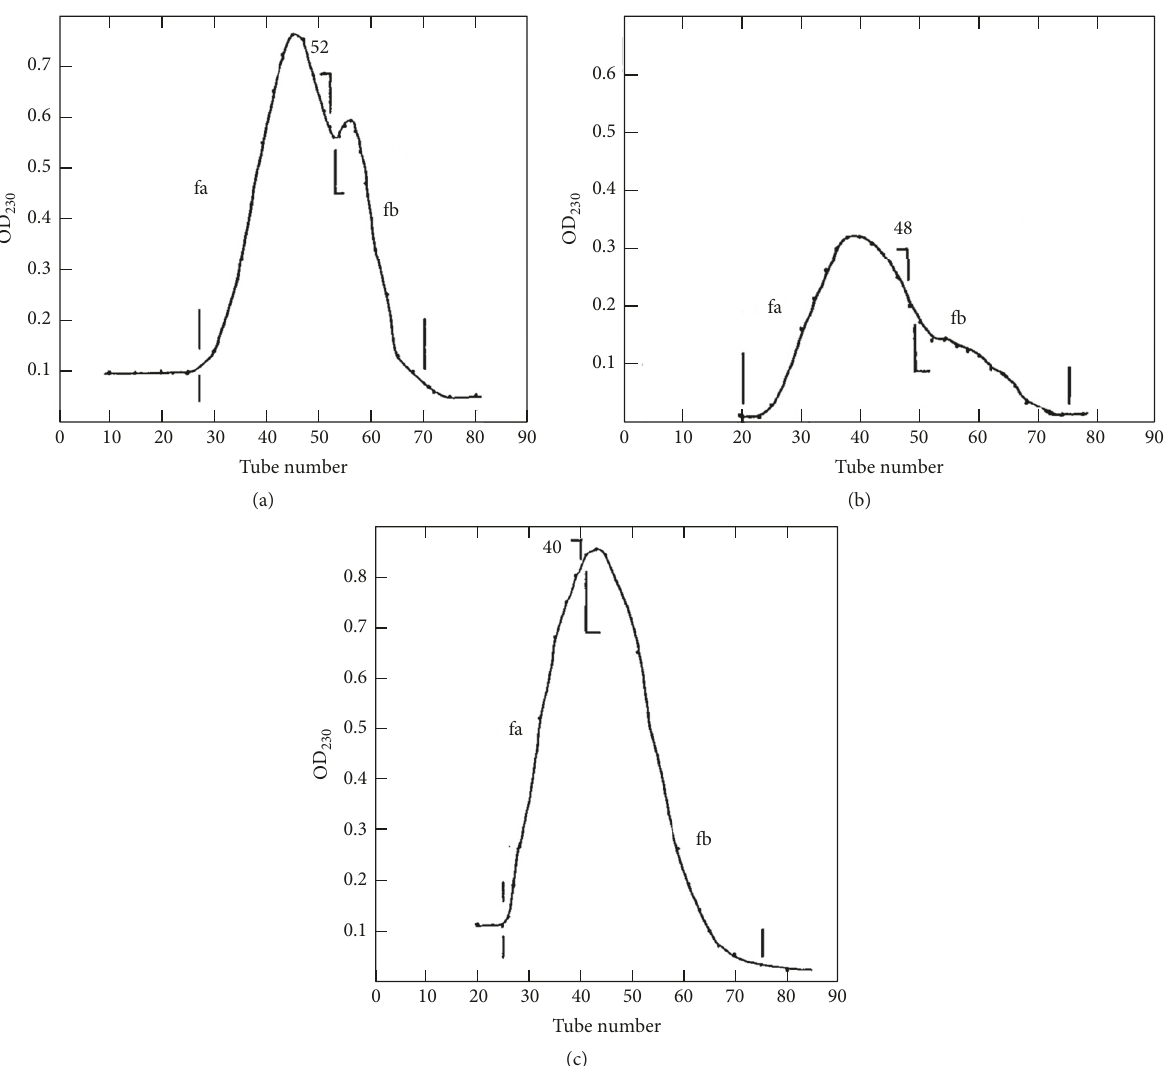
Figure 9: Gel permeation chromatograms of the reaction mixtures of peptide derivatives under different conditions. (a) Boc-L-Ala-L-Asp, 130 ∘ C, 1h; (b) Boc-L-Val-L-Asp, 130 ∘ C, 2h; and (c) 120 ∘ C, 4 h. Solid phase: Sephadex G-25F. Eluate: 0.5 M acetic acid. Volume per a test tube: 3 mL. fa: ninhydrin-negative, higher molecular weight fractions; fb: ninhydrin-positive lower molecular weight